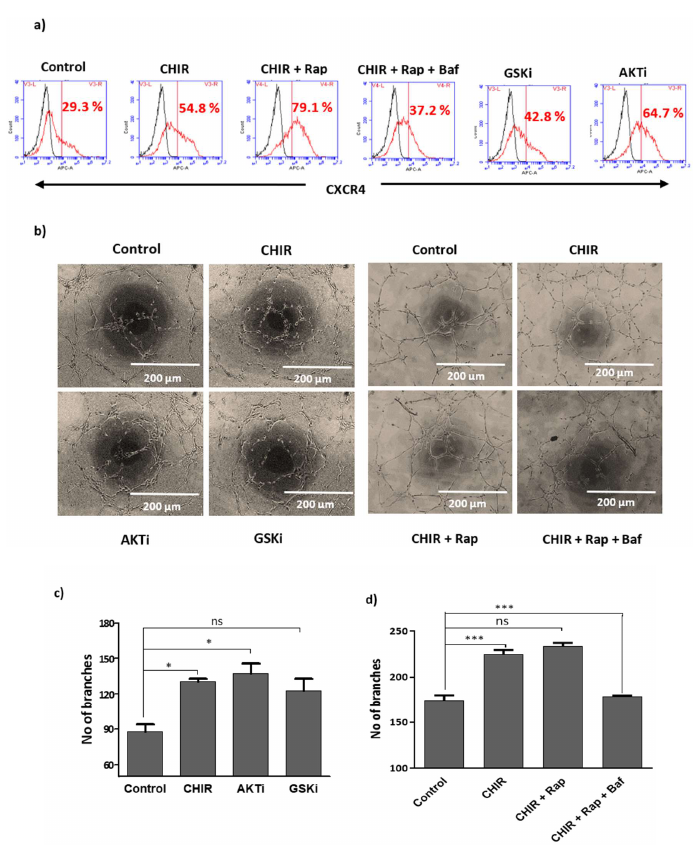
Figure 4. Lysosome activation and autophagy by CHIR99021 expands endothelial functional activ- ity of late EPCs: ( a ) Cells were single treated with CHIR99021 (3 μM), and GSK 3β specific inhibitor (3 μM) for 24 h, and AKT 1/2 inhibitor (3 μM) for 1 h, then subsequently co-treated with Rapamycin (20 nM) and bafilomycin A1 (5 nM) for 1 h. FACS was performed for gating the population of non- stained cells as a negative control. The fraction of positively stained cells was determined by com- parison with non-stained cells. The fraction of positively-stained cells is indicated by the positive peaks (red line indicates cells stained with each antibody, and black lines indicate the negative con- trol). ( b ) Endothelial functional activity of EPCs was established using vascular network formation. Cells treated with CHIR99021 (3 μM), AKT 1/2 inhibitor (3 μM), GSK 3β inhibitor (3 μM) either in presence or absence of Rapamycin (20 nM) and Bafilomycin A1 (5 nM) for 6 h. The vascular structure was visualized using a light microscopy, the branches were quantified using ImageJ. ( c,d ) The num- ber of branches were also quantified. Data are presented as mean ± standard error of the mean (SEM). The results are considered statistically significant at * p < 0.05; ** p < 0.01; *** p < 0.001 when compared to untreated groups. (Baf-bafilomycin A1, Rap- Rapamycin, AKTi- AKT inhibitor, GSKi- GSK inhibitor).